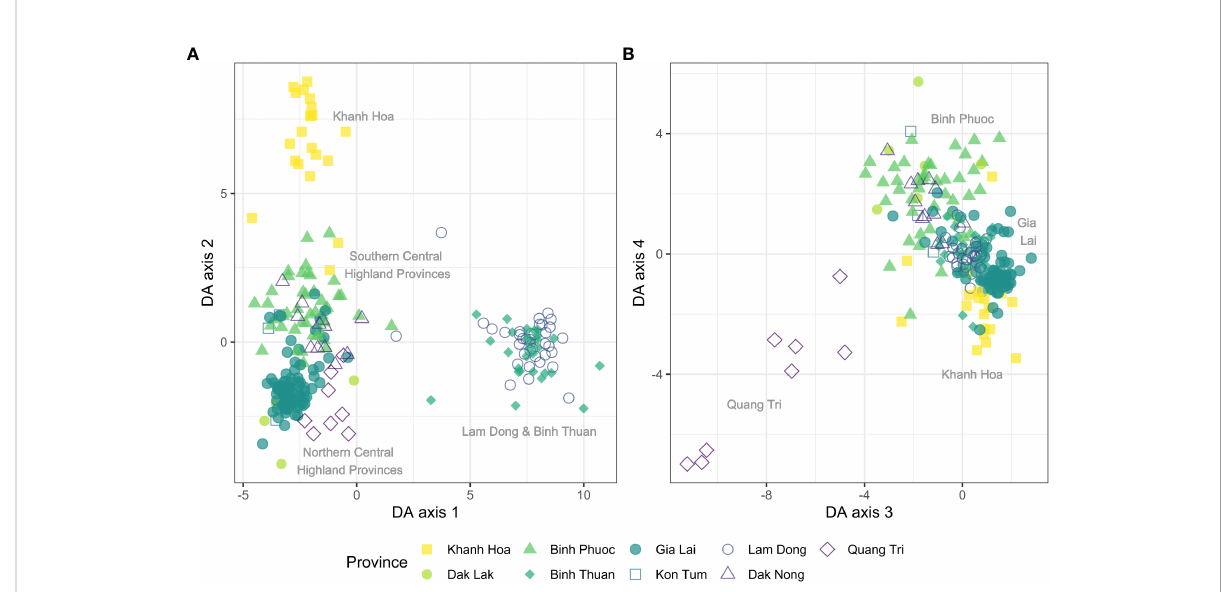
FIGURE 7 Discriminant analysis of principal components (DAPC) of Vietnam isolates (n = 261) grouped by province. Scatter plot of DA eigenvalues 1 and 2 (A) using all biallelic SNPs detected by the Pv AmpliSeq showed a differentiation of Lam Dong and Binh Thuan along the x-axis and a separation of Khanh Hoa province along the y-axis. Scatter plot of DA eigenvalues 3 and 4 (B) groups separately clusters isolates from the most Northern province of Quang Tri. SNPs contributing most to the DAPC are listed in Supplementary Table 2, Table S6. DAPC was performed with 60 principal components and 8 discriminants as determined through